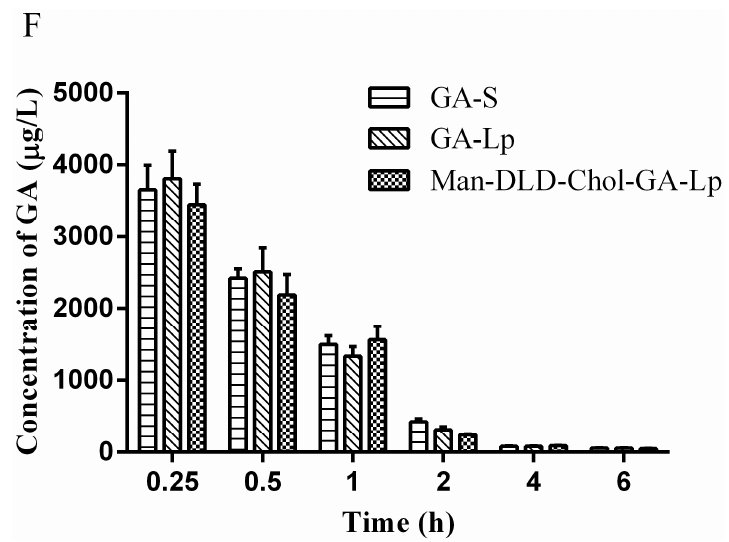
Figure 8. Concentration of GA in various tissues and plasma of mice after intravenous administration (n = 5). ( A ) Heart; ( B )liver; ( C ) spleen; ( D ) lung; ( E ) kidney; and ( F ) plasma. Table 4. Linear equation, linear coefficients, and linear ranges of GA in plasma and tissues.